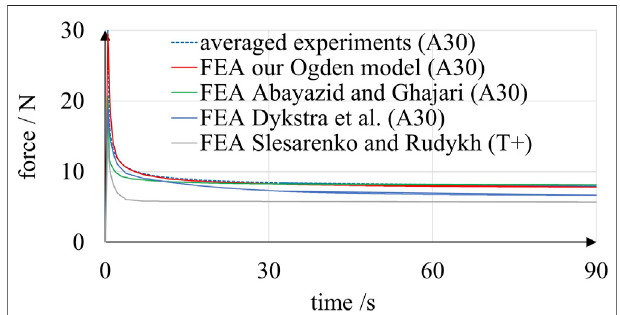
FIGURE 9 | Results of simulated and experimental relaxation of A30 linearbellowsactuators.Thesimulationsbasedonseveralmaterialmodelsare clearly capable of reproducing the characteristic exponential decay of the experimentally determined reaction